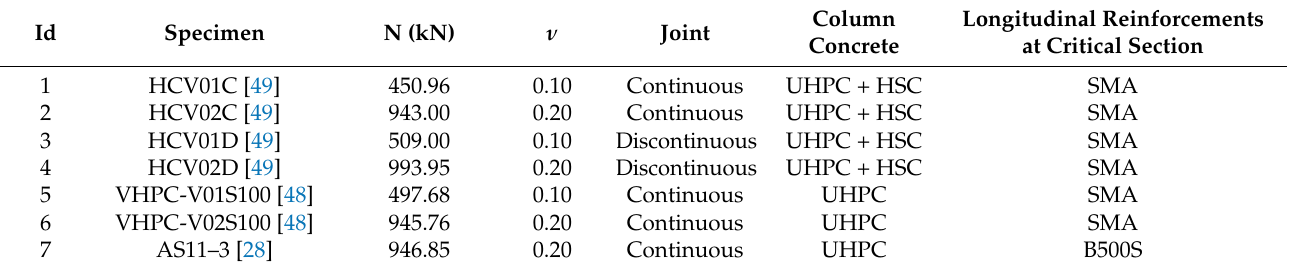
Table 1. Details of